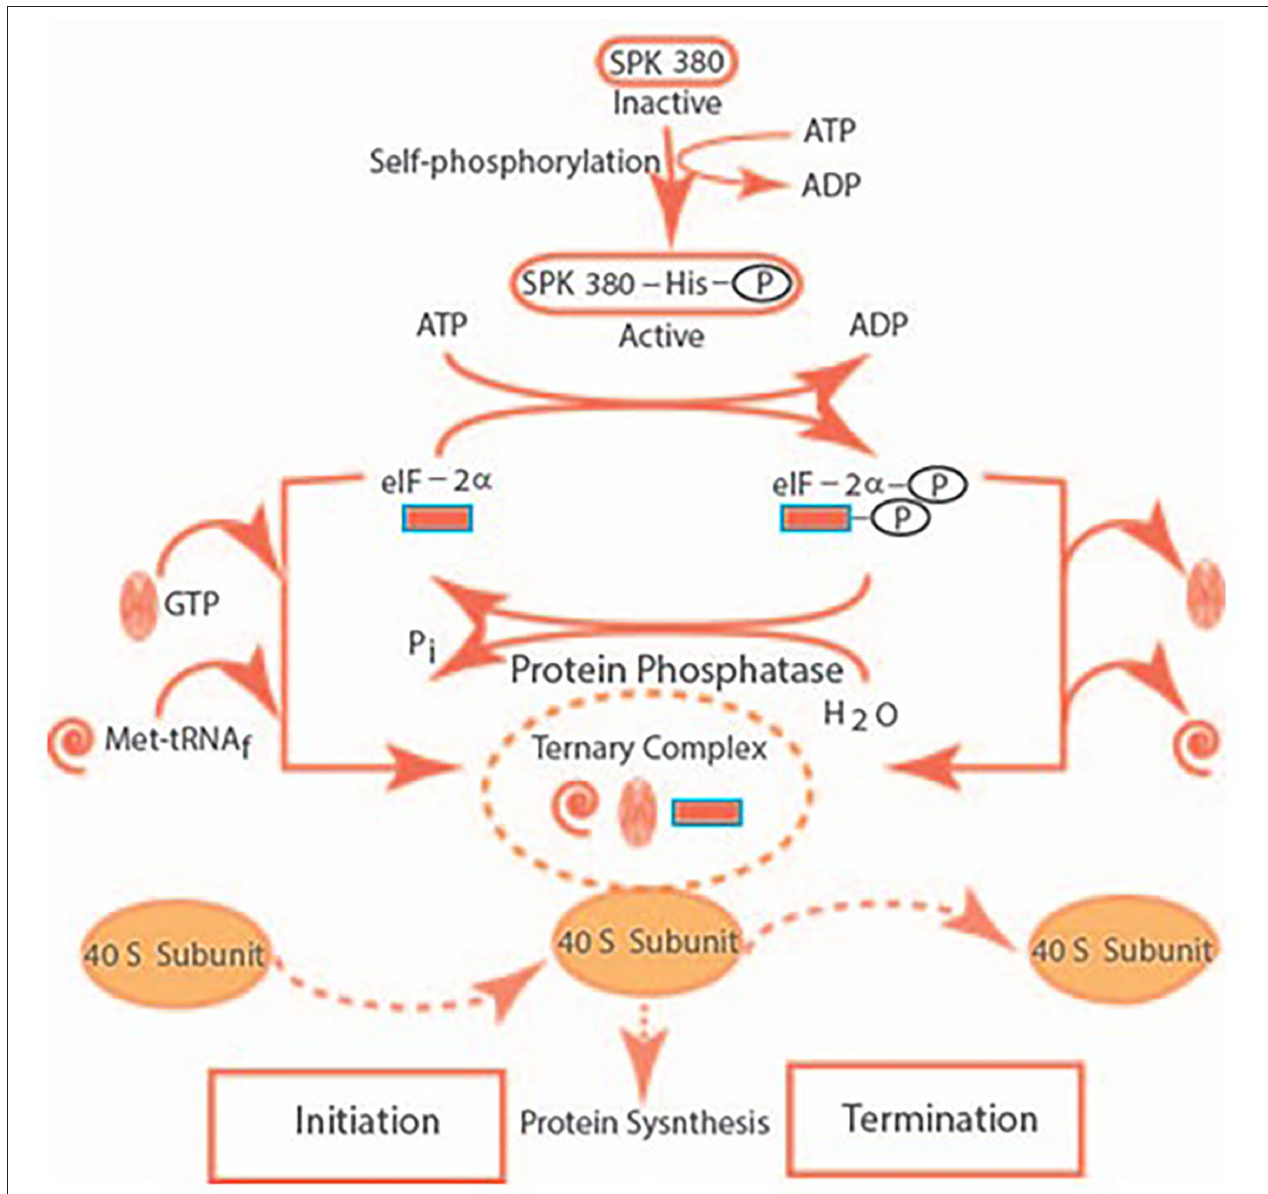
FIGURE 3 | The SPK self-phosphorylates its histidine residue and transforms itself from its inactive to the active form. It catalyzes the phosphorylation of the serine residue of eIF-2 α . The eIF-2 α -P dissociates the ternary complex of GTP, Met-tRNA f , and the 40S ribosomal subunit. It results in the termination the of initiation of the protein synthesis. The ternary complex is restored after de-phosphorylation of eIF-2 α , thus, restoring protein